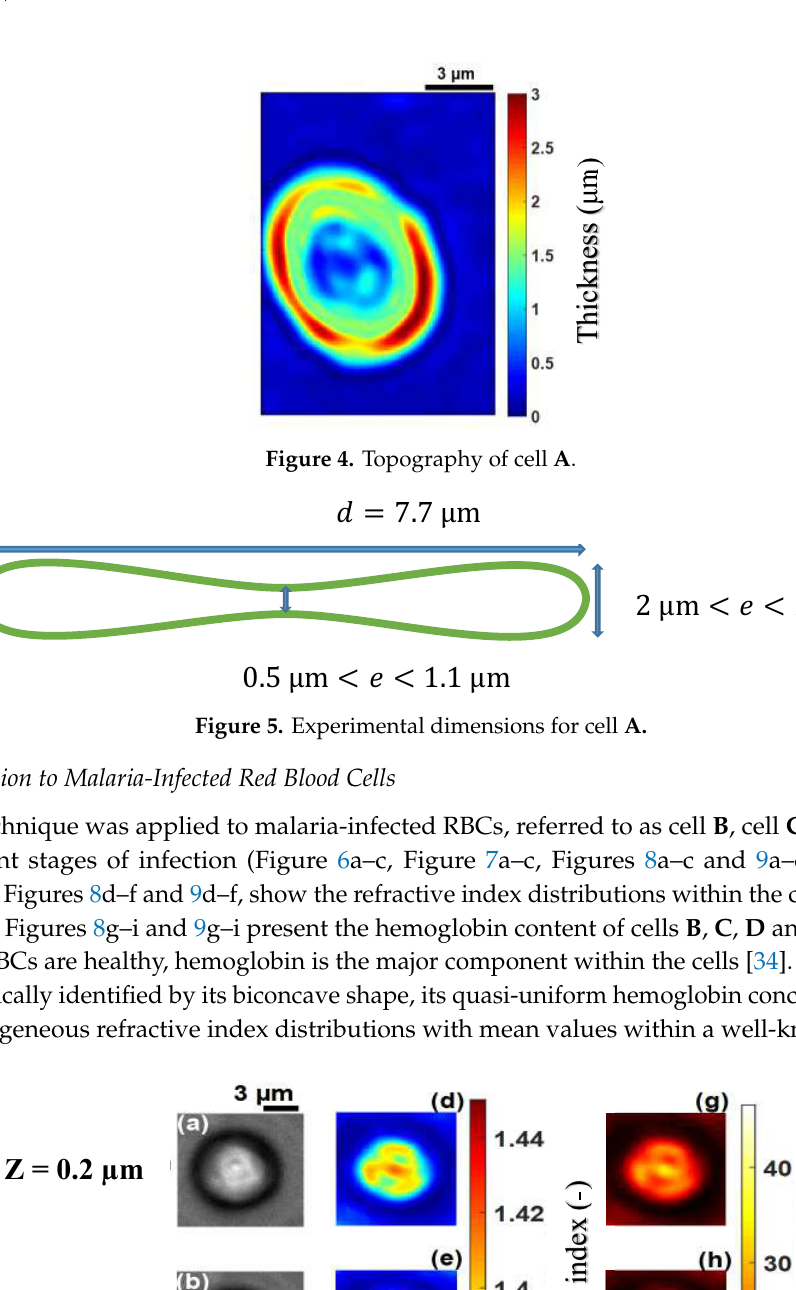
Figure 9. Recorded images of infected cell E at the schizont stage, at the wavelength λ = 800 nm for different z planes ( a )–( c ), its corresponding refractive index distribution ( d )–( f ) and hemoglobin content ( g )–( i ). The selected images are representative of a total of 28 cells analyzed.